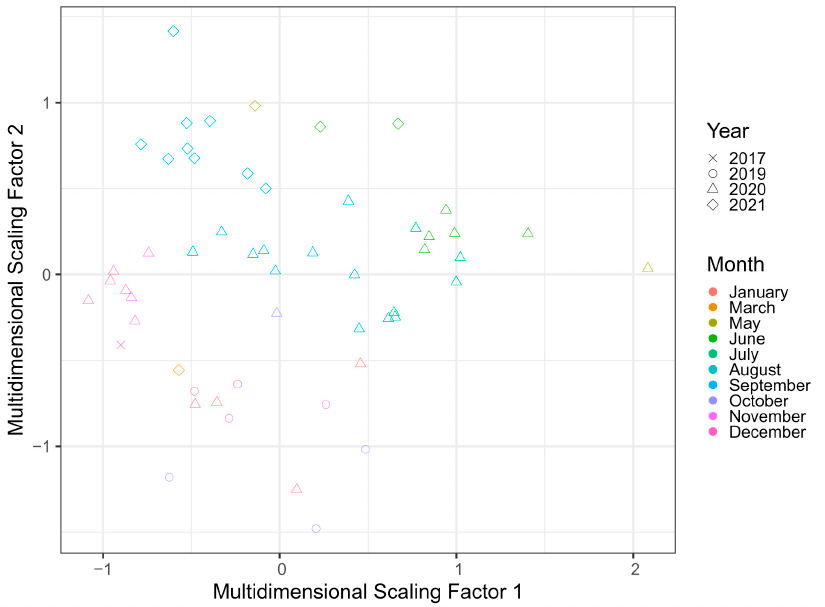
Figure 5. Fisher’s alpha diversity index over time. Background shading and boxplot colors indicate stages in the annual cycle (dark grey shading, over ‐ wintering; light grey shading, migration; green boxplots, summer; yellow box plots, fall; orange boxplots, winter; blue boxplots, spring). Boxplots show the median and interquartile range; whiskers include all observations within 1.5 x IQR (inter ‐ quartile range), and outliers are represented by points.